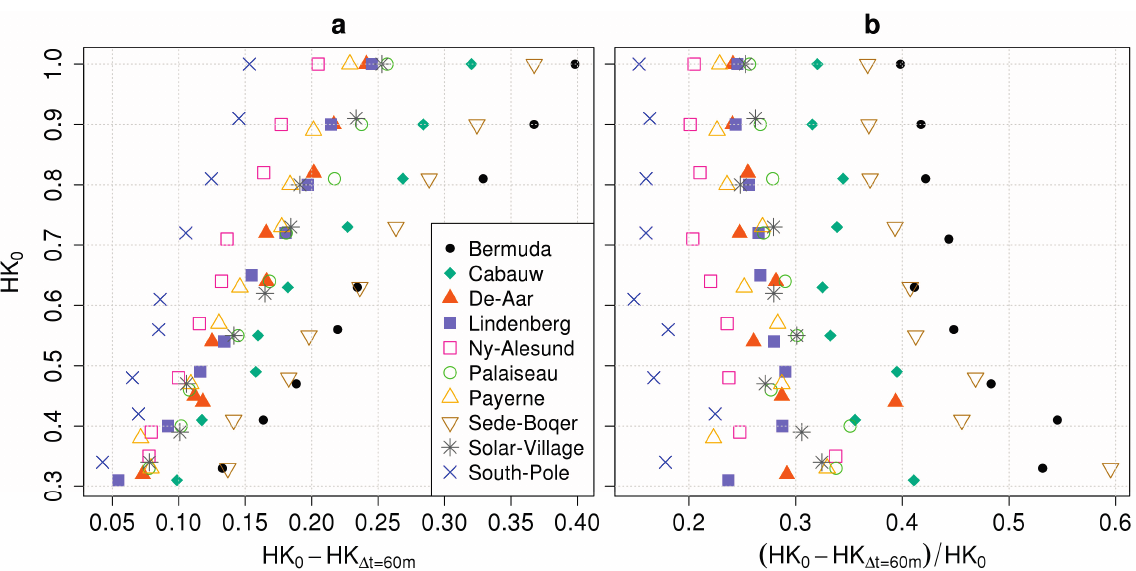
Figure 5. The mean bias of the Hanssen-Kuiper’s discriminant when allowing for the maximum time difference of 60 min (HK Δ t = 60m ) in dependence of the unbiased skill score (HK 0 ) presented as ( a ) absolute and ( b ) relative value.